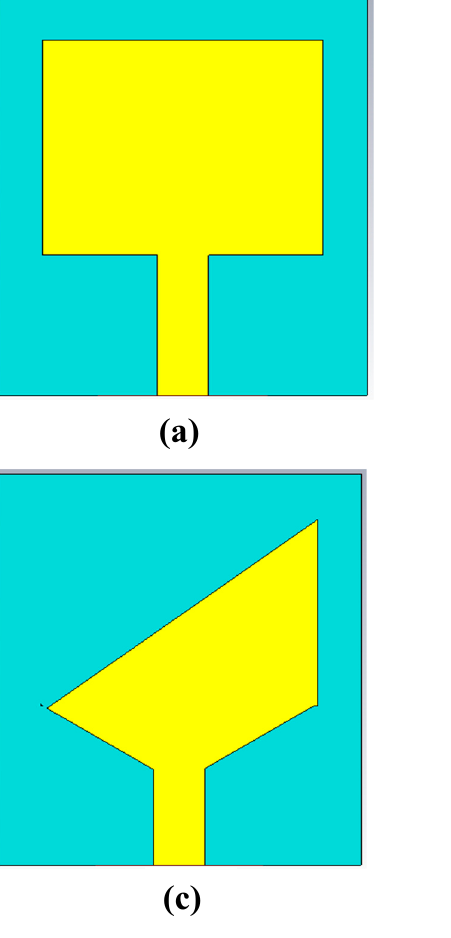
Figure 8. Structural parametric analysis of antenna ( a ) patch structure-1 ( b ) patch structure-2 ( c ) patch structure-3 and ( d ) patch structure-4. Table 3. Comparison of the radiating patch e ff ects on voltage standing wave